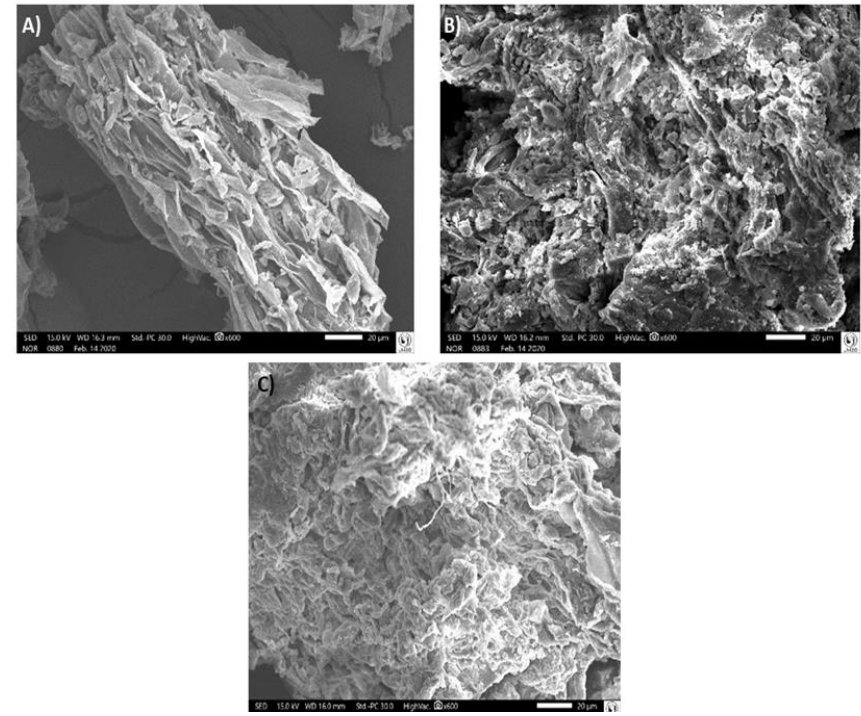
Figure 3. Scanning electron microscopy (SEM) of particles from stalks of champignon ( A ); stalks of champignon after 20 min of contact with Cu ( B ); and stalks of champignon after 120 min in contact with Pb ( C ). Magnification of 600×.